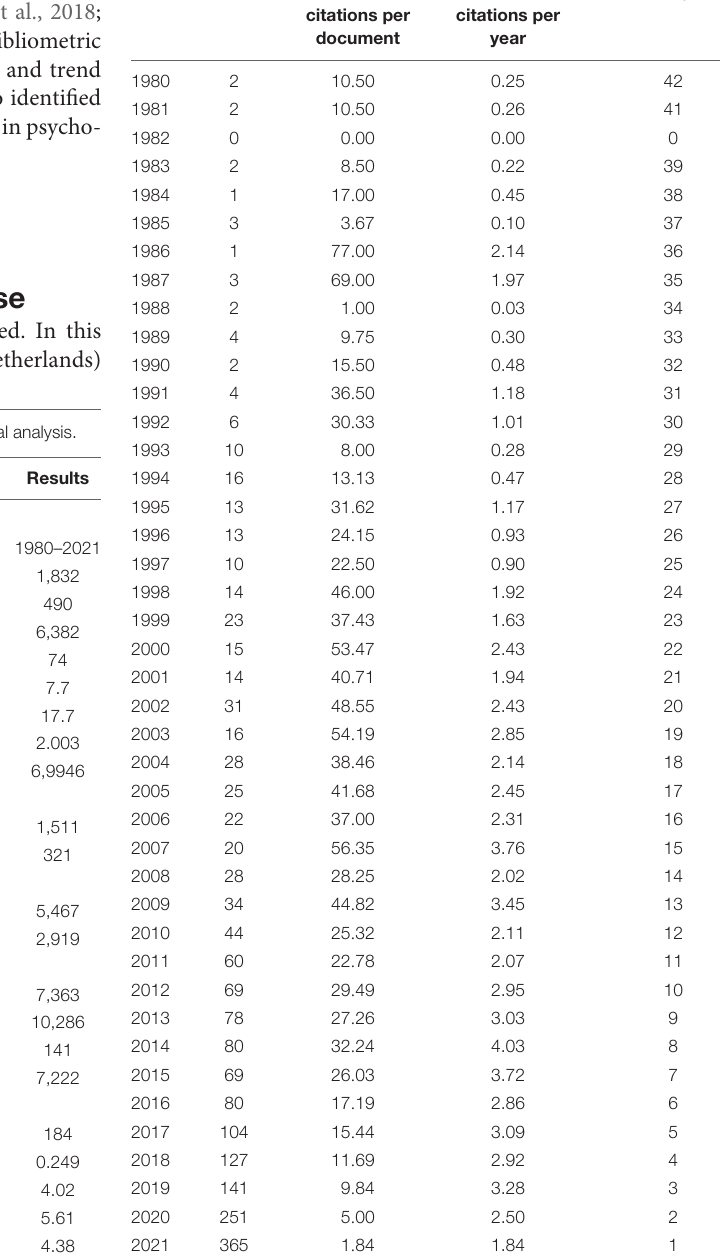
TABLE 2 | Annual scientific production and mean